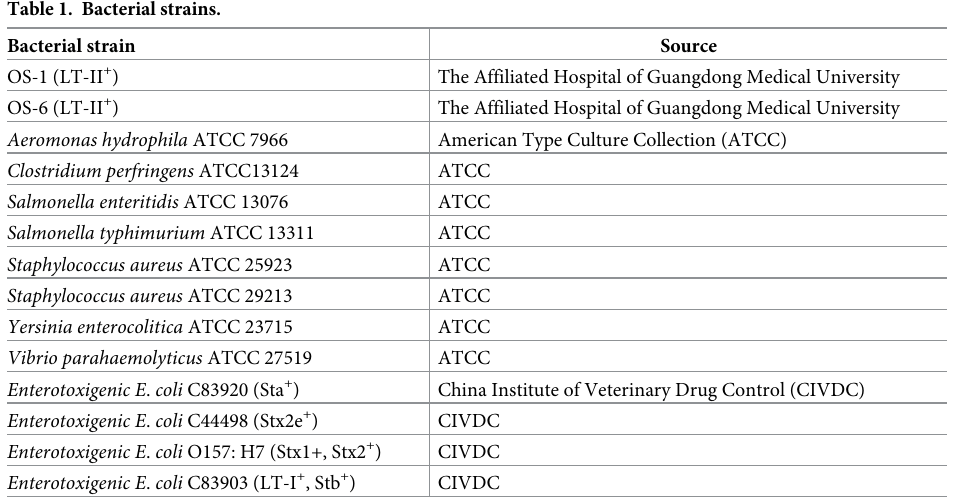
Table 1. Bacterial strains. Bacterial